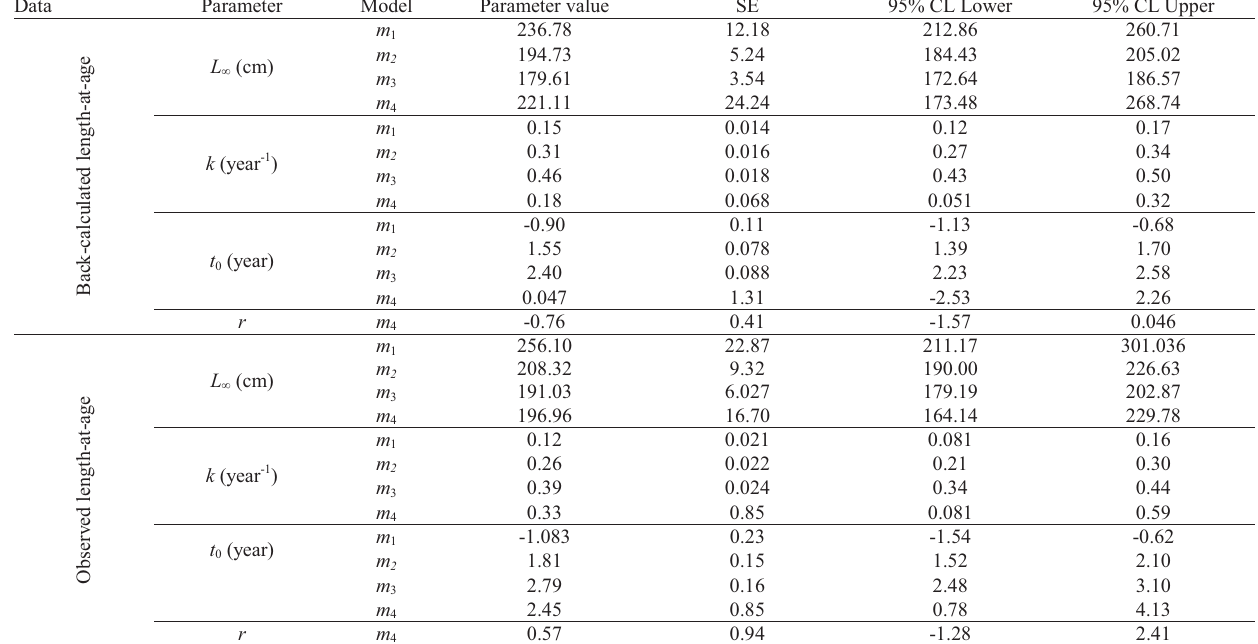
Table 3. Growth parameters with corresponding standard error (SE) and 95% confidence limits (CL) estimated for each candidate model using back-calculated and observed length-at-age data. m m = Richards. 4